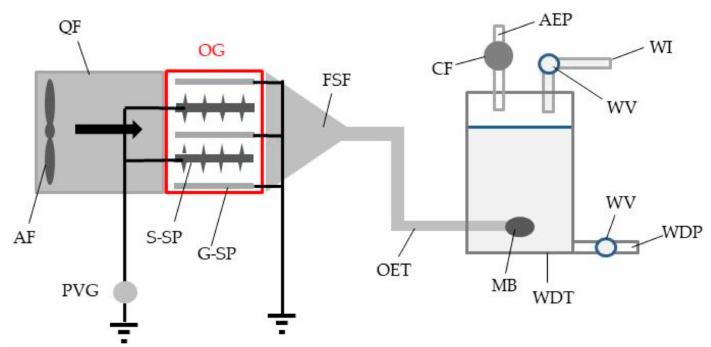
Figure 2. Schematic representation of an ozone generator (OG) devised for sterilising phages trapped in the grounded water. The arrow represents the direction of wind from AF. PCC, polyvinyl chloride cylinder; AF, axial fan; PVG, positive voltage generator; S-SP, spiked stainless plate; G-SP, grounded stainless plate; FSF, funnel-shaped pipe fitting; OET, ozone-ejecting tube; CF, activated charcoal filter; AEP, air exhaust port; WV, water valve; WI, water inlet; MB, micro-bubbler; WDT, water-drain tank; WDP; water-drain